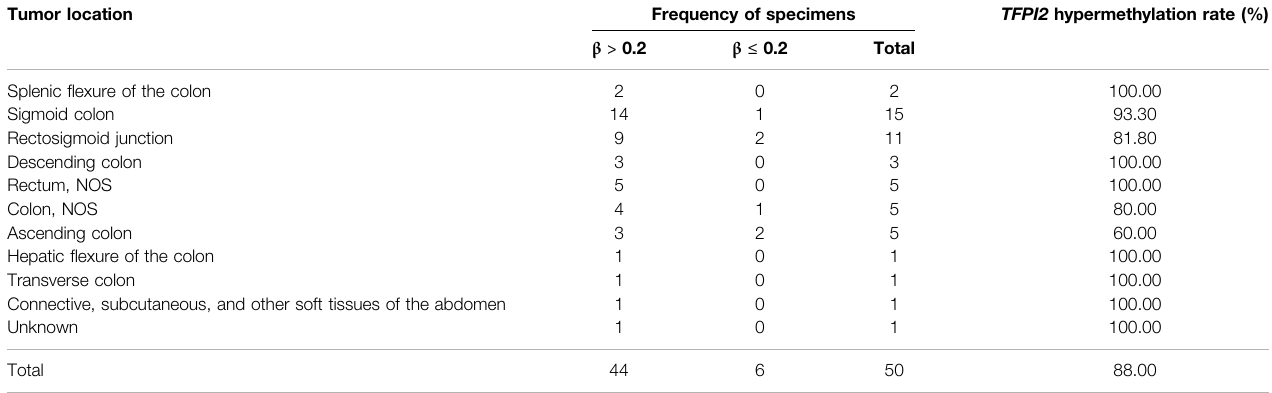
TABLE 2 | Detection rate of TFPI2 in colorectal cancer tissues with the SDC2 β value lower than 0.2. Tumor